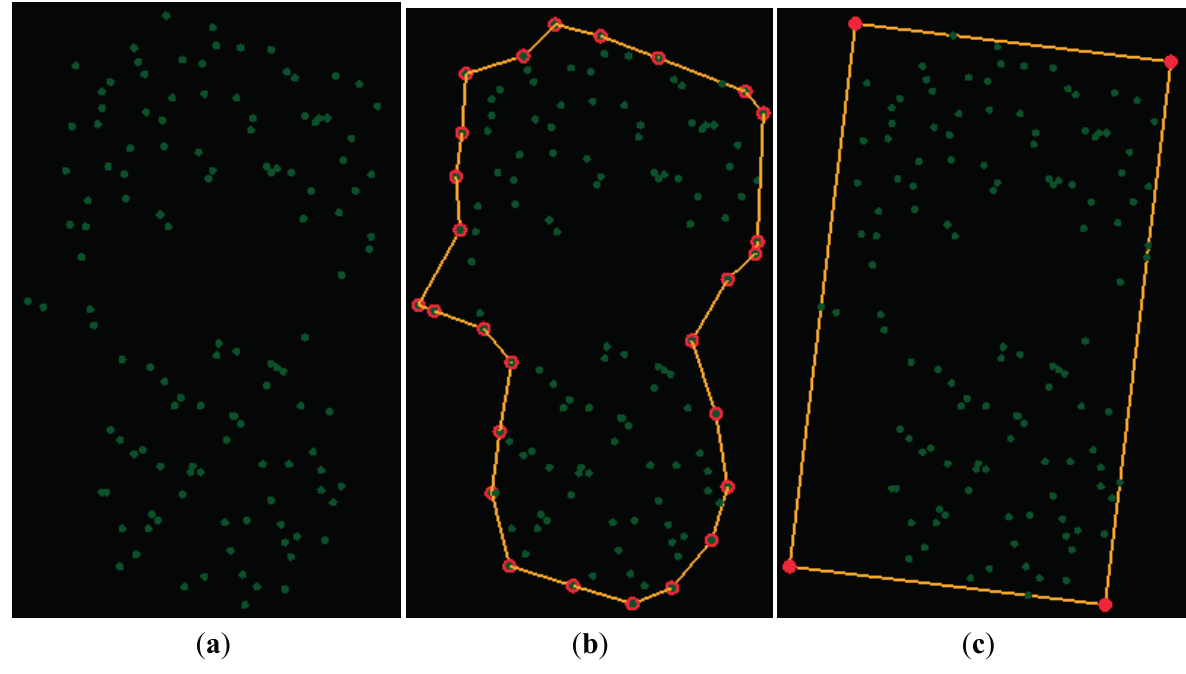
Figure 4. Calculation of 2D geometric properties of a cluster of points belonging to the same vehicle. ( a ) The original points. ( b ) Top view of the 3D boundary of the points. ( c ) Minimal oriented bounding box (MOBB) of the points. ( d ) Perspective view of 3D boundary of the points. Note that the laser points are colored in greed, the boundaries are colored in yellow and the boundary points are colored in